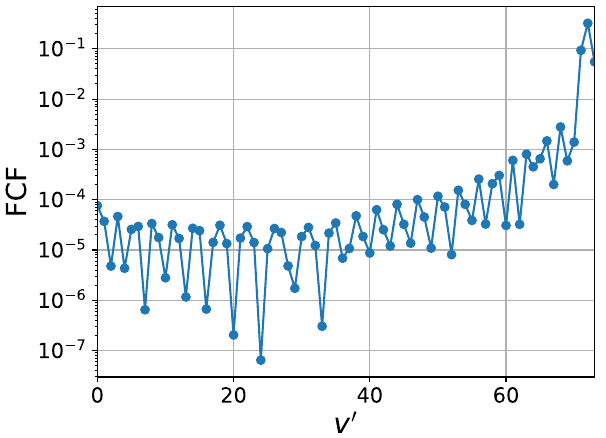
FIG. 8. The Franck-Condon factor (FCF) between the target molecular state and vibrational state v 0 of c 3 Σ þ 1 . The potential supports 74 bound states, and the predominant contribution arises from the near-threshold bound states. The total overlap with all the bound states is 0.4822, which is 96.8% of the total triplet fraction of the target molecular state.